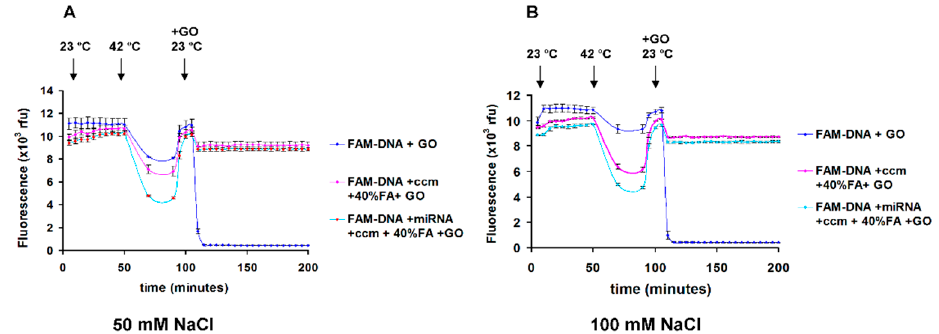
Figure 5. MicroRNA (18 nt) detection by fluorescence PET quenching in cell culture medium with increased ionic strength, ( A ) 50 mM NaCl, ( B ) 100 mM NaCl. The experiments were done in triplicate samples. Error bars represent the standard deviations of triplicate values.